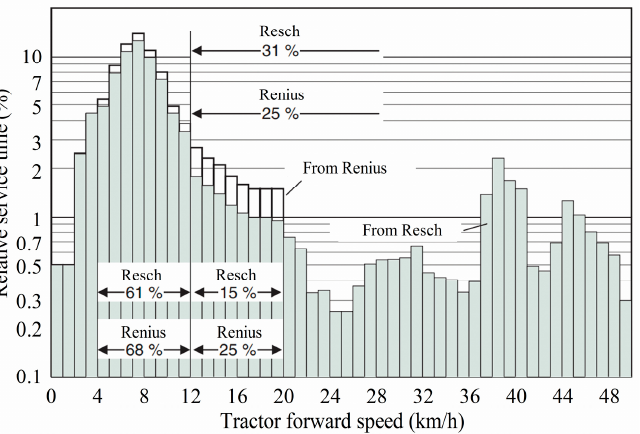
Figure 2. The speed statistics of a tractor throughout its life cycle from Resch and Renius [26].